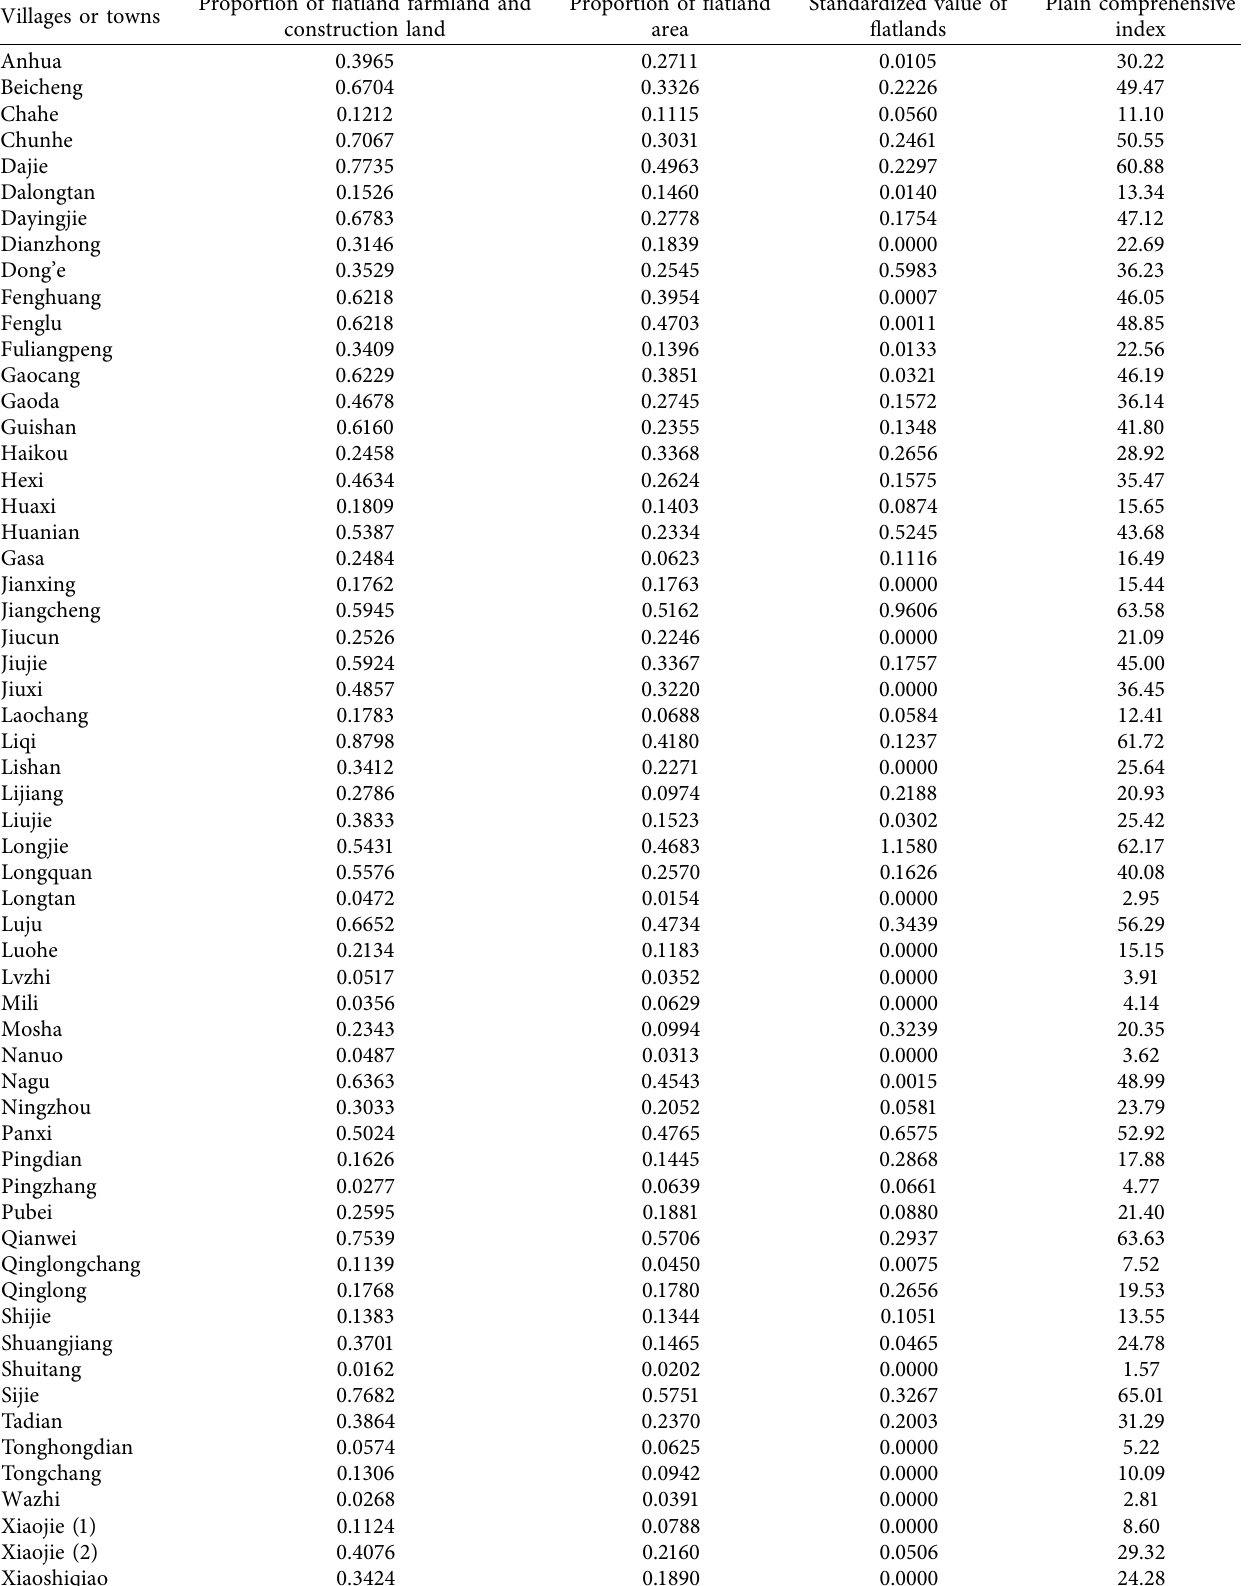
Table 5: Mountainous areas and plain areas classification index of each villages or